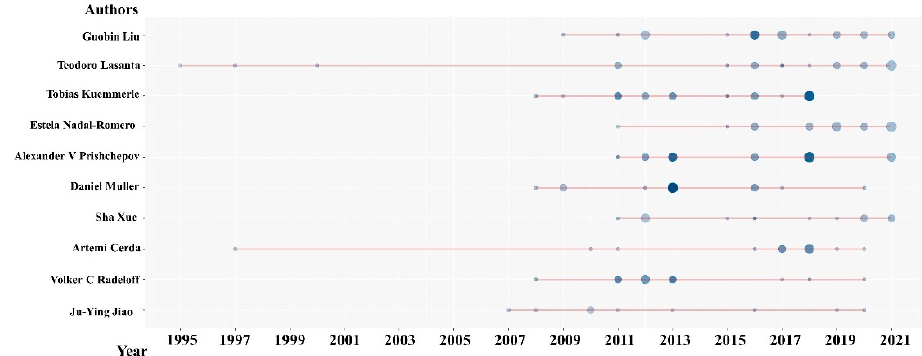
Figure 6. Works of different authors in the field of farmland abandonment over time (Note: N. Articles = number of articles; TC per Year = total citations per year).